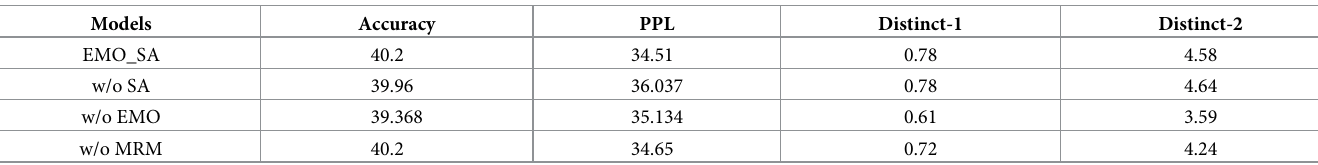
Table 4. Ablation